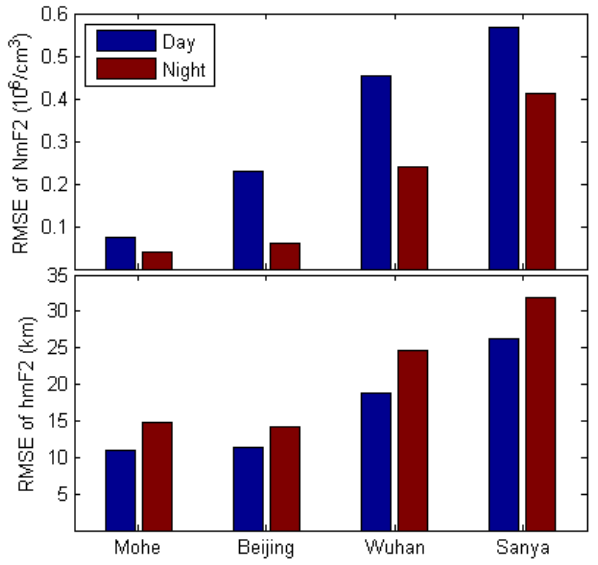
Figure 6. Root mean square errors of Nm F2 and hm F2 from COS- MIC and ionosonde measurements during the day and